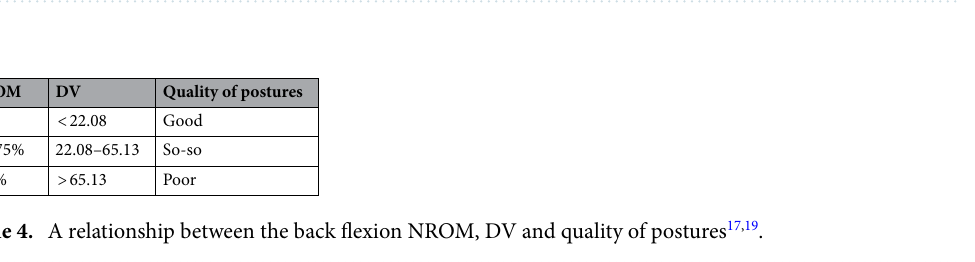
Table 3. Different qualities of correlation of the muscle activation 37,38 .